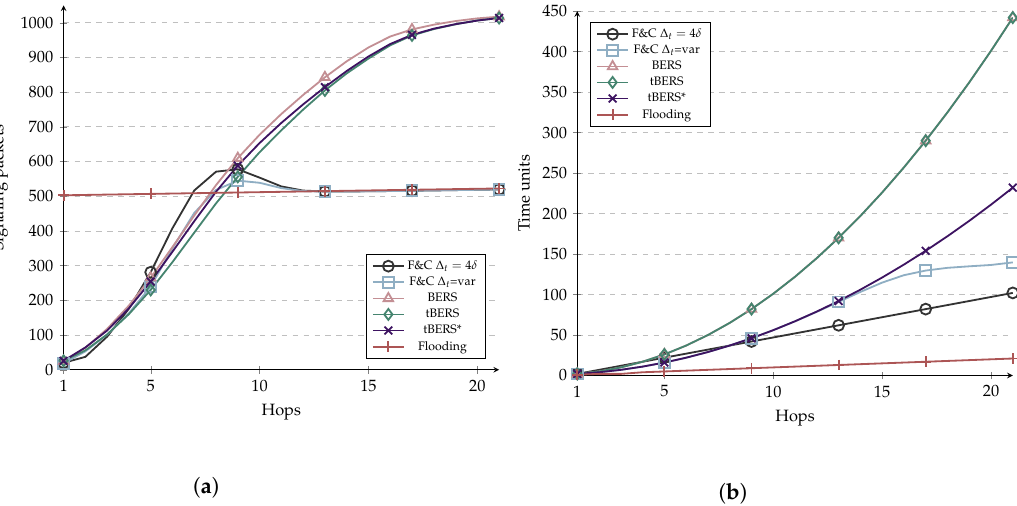
Figure 13. Comparison of flooding contention protocols. ( a ) Signaling overhead; ( b ) Route discovery